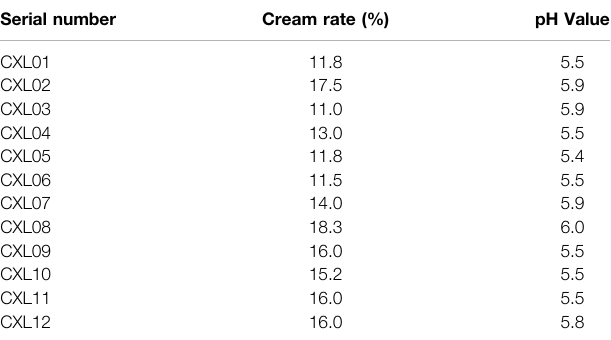
TABLE 3 | Cream rate and pH value of standard